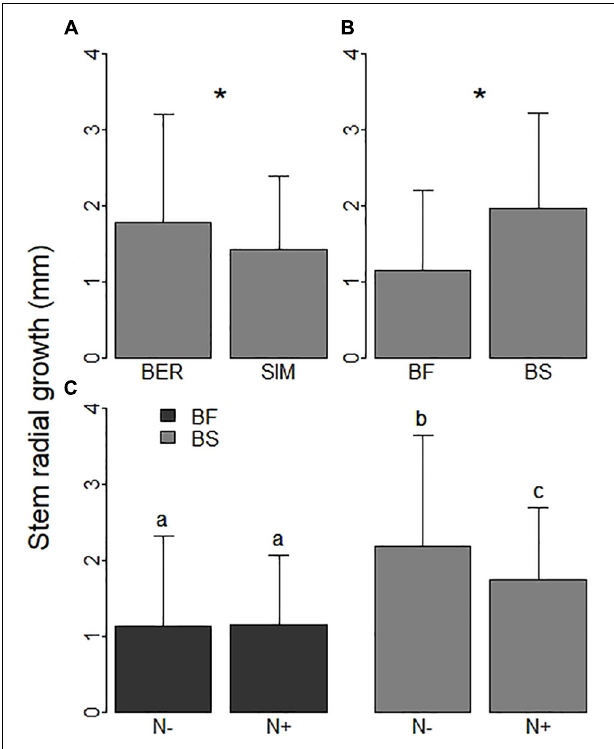
FIGURE 4 | Seedlings’ stem radial growth (mm) (A) at the BER and SIM sites; (B) for balsam fir (BF) and black spruce (BS); and (C) in fertilized (N + ) and unfertilized (N − ) plots in both species. * indicates significant differences ( P < 0.05). Values not sharing the same letter are significantly different ( P <